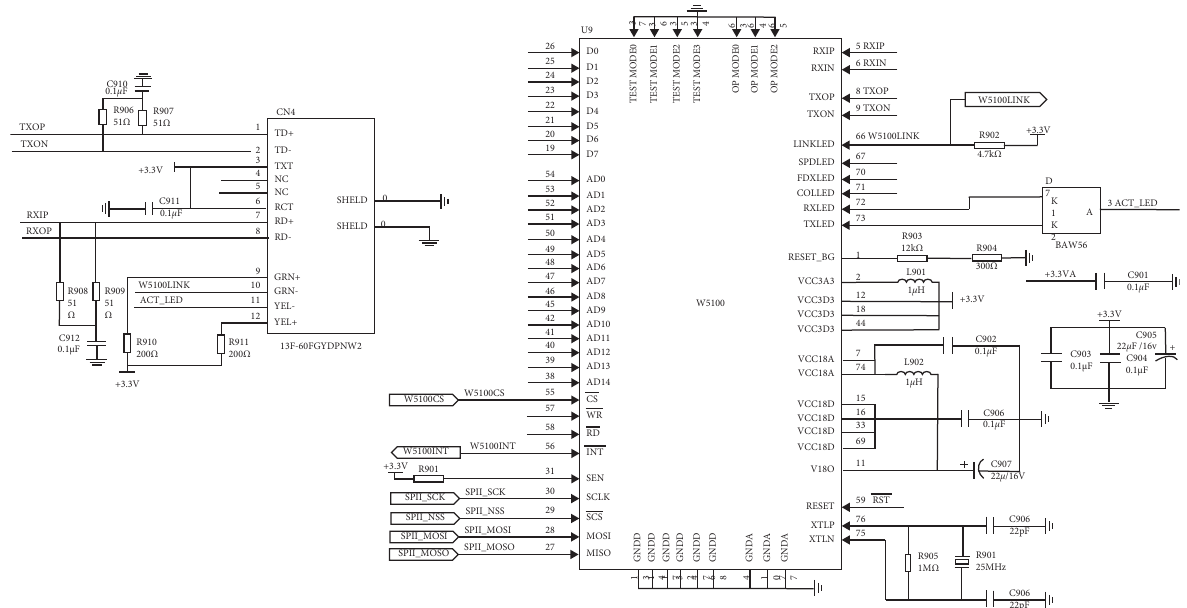
Figure 4: Hardware circuit structure of the node.